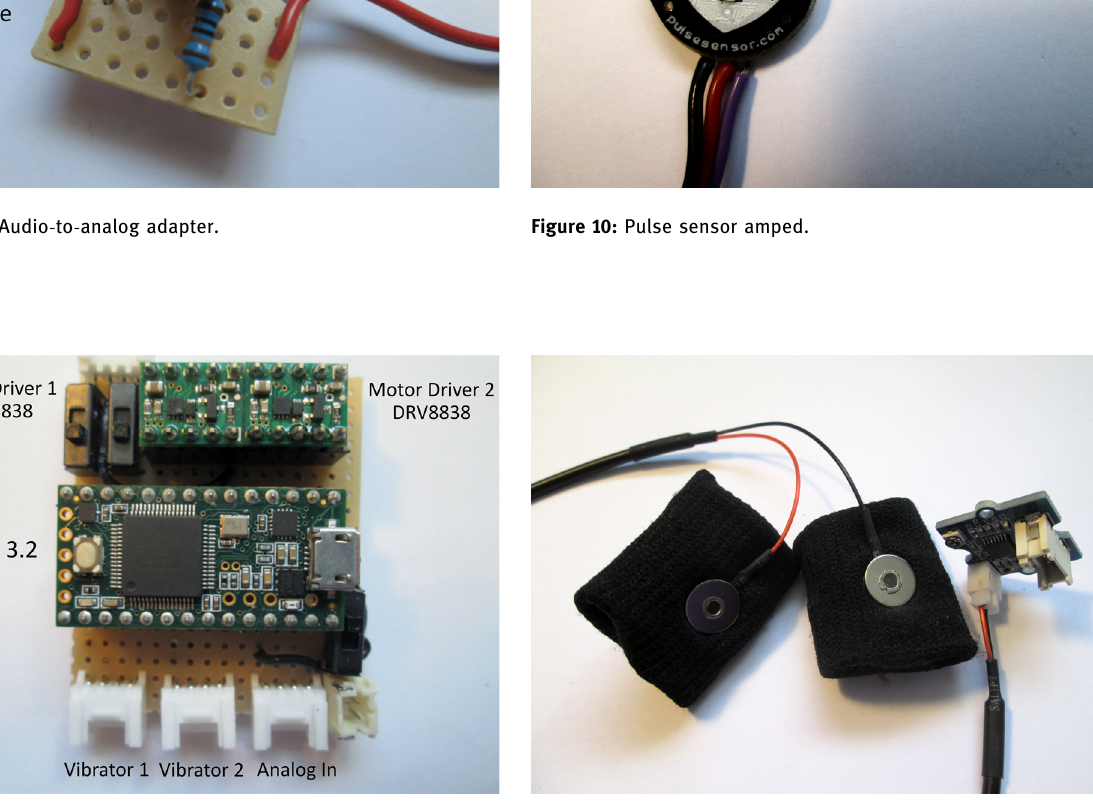
Figure 11: Grove - GSR